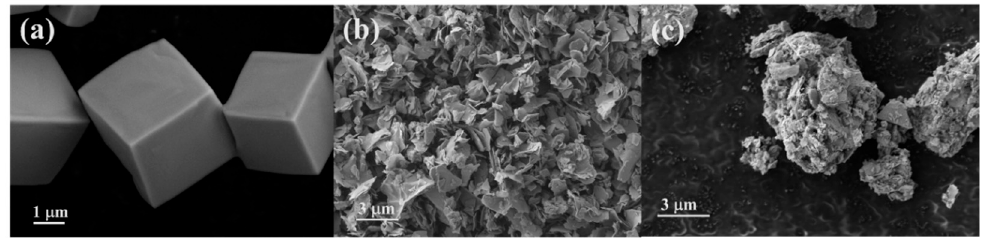
Figure 2. SEM images for ( a ) NaCl, ( b ) Pt/Y 2 O 3 -NaCl, and ( c ) Pt/Y 2 O 3 .